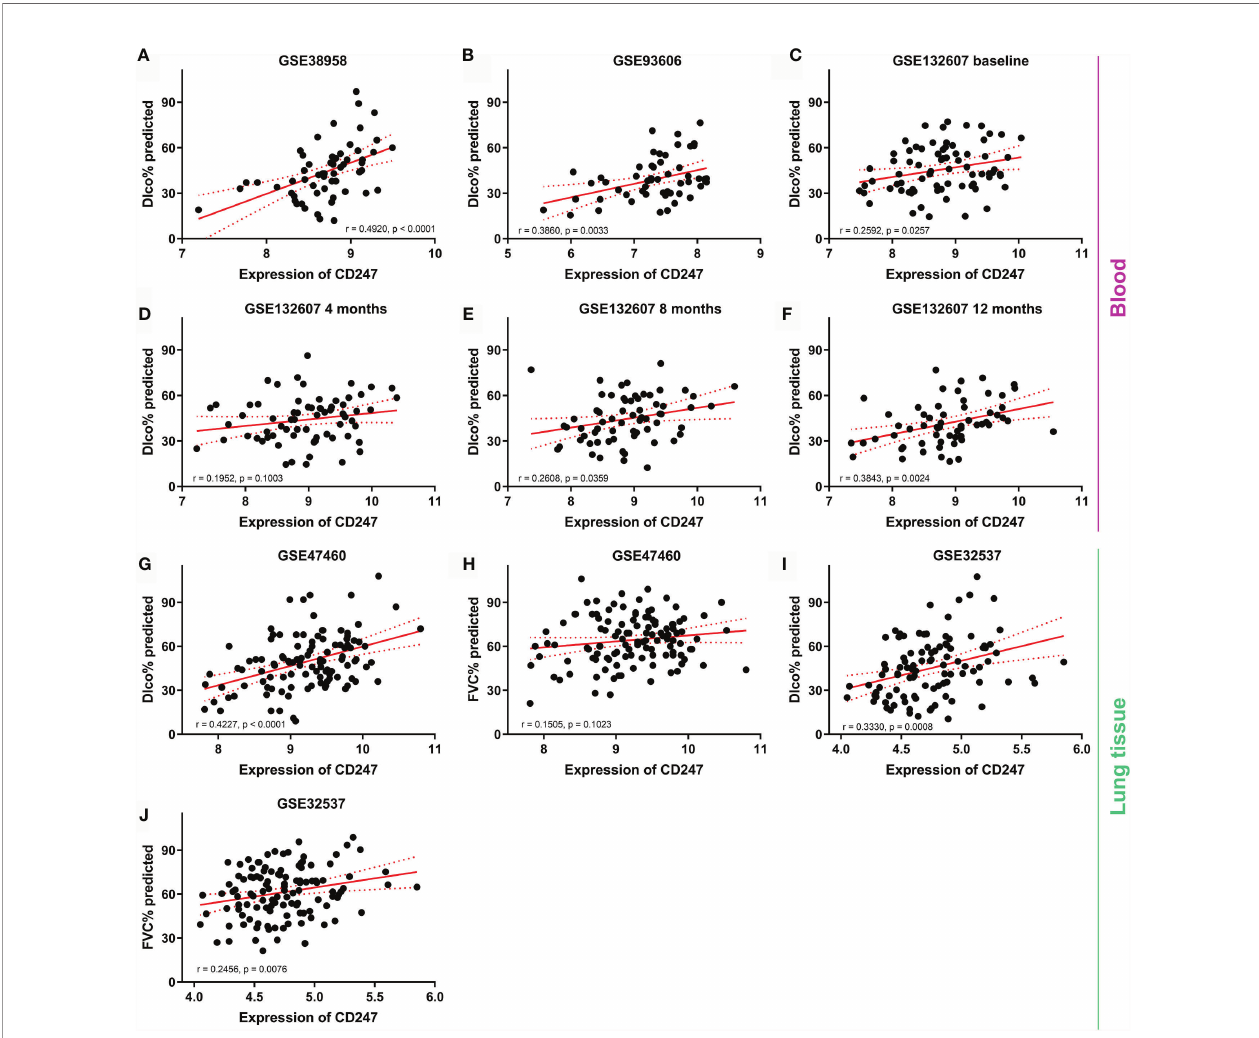
FIGURE 3 | The correlation between CD247 expression and lung function. Blood: GSE38958 dataset (A) , GSE93606 dataset (B) , visiting at 0, 4, 8, and 12 months in the GSE132607 dataset (C – F) . Lung tissue: GSE47460 dataset (G, H) and GSE32537 dataset (I, J)